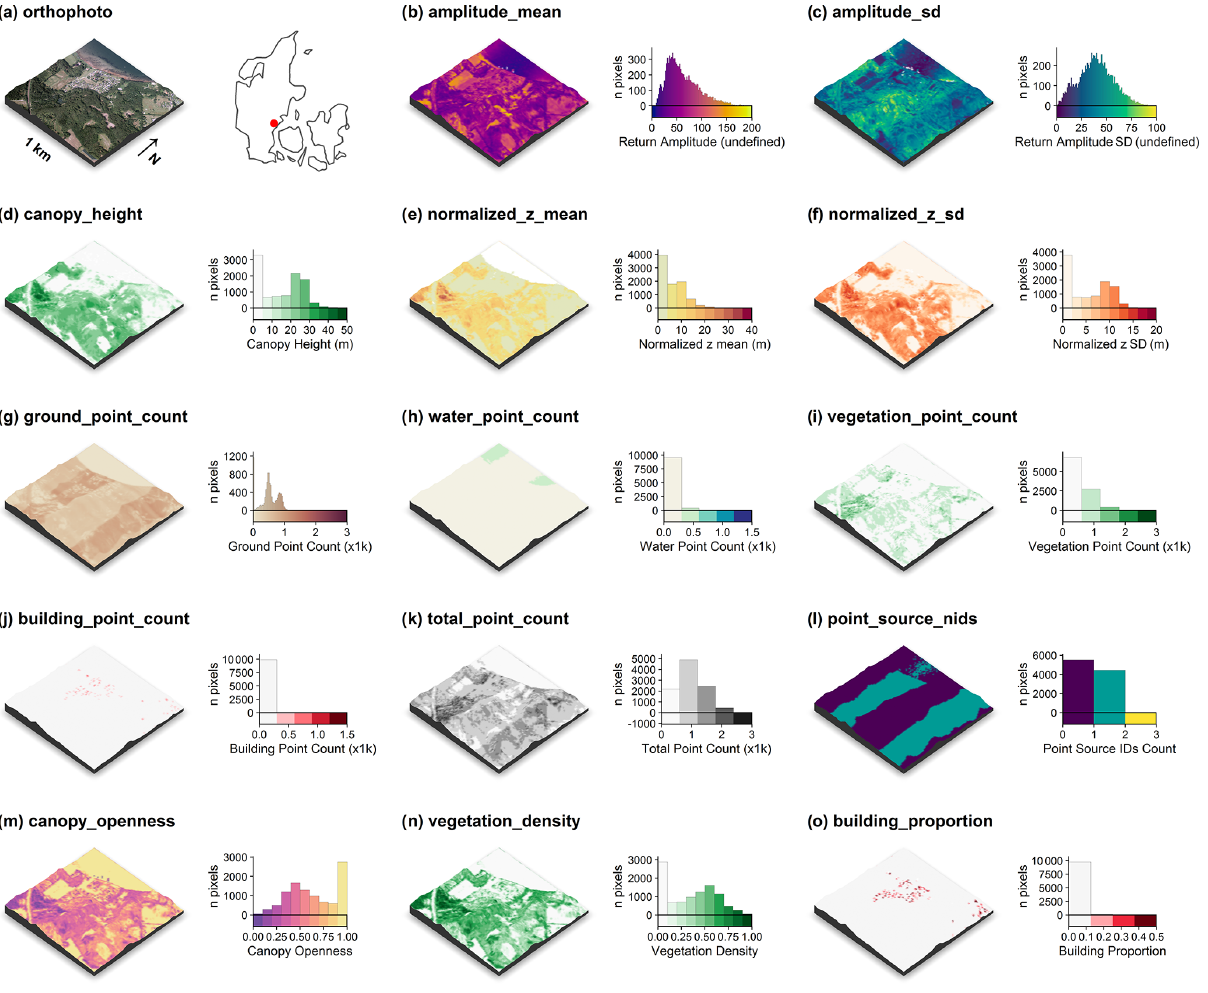
Figure 4. Illustration of the point-cloud-derived descriptors for a 1km × 1km tile along Vejle Fjord (tile id: 6171_541). An orthophoto and the tile location relative to Denmark are shown in (a) . The point-cloud-derived descriptors are comprised of (c) the mean return amplitude, (d) the standard deviation in the return amplitude, (e) the canopy height (vegetation returns only), (f) the mean of the normalized height above ground (all returns), (g) the mean of the normalized height (all returns), (h) the ground point count, (i) the water point count, (j) the building point count, (k) the total point count, (l) the number of point sources (flight strips), (m) the canopy openness, (n) the vegetation density and (o) the building proportion. Note the influence of point source overlap illustrated in (l) on some of the descriptors, for example, (g) ground point count, (i) vegetation point count and (k) total point count (see Sect. 3.5.5 for detail). For visualisation purposes, we amplified the altitude above sea level by a factor of 2 in the three-dimensional visualisations and divided the point counts by 1000. The three-dimensional raster visualisations were generated using the rayshader v0.19.2 package in R (Morgan-Wall, 2020). Orthophotograph provided by the Danish Agency for Data Supply and Efficiency (https://sdfe.dk/hent-data/fotos-og-geodanmark-data/, last access: 28 June